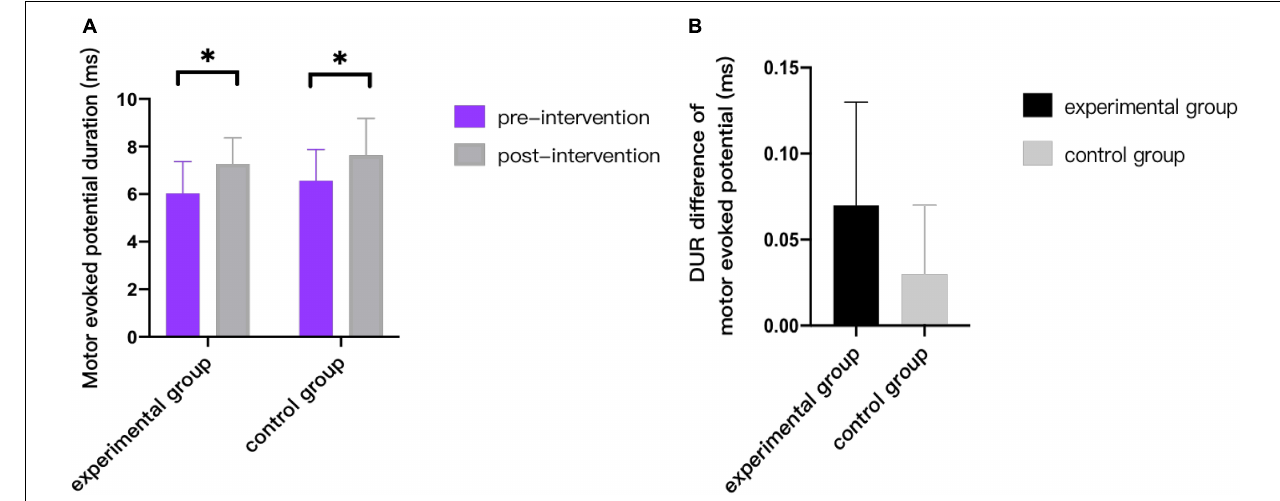
FIGURE 9 | Comparison of duration of motor evoked potentials. * indicates intra-group p <